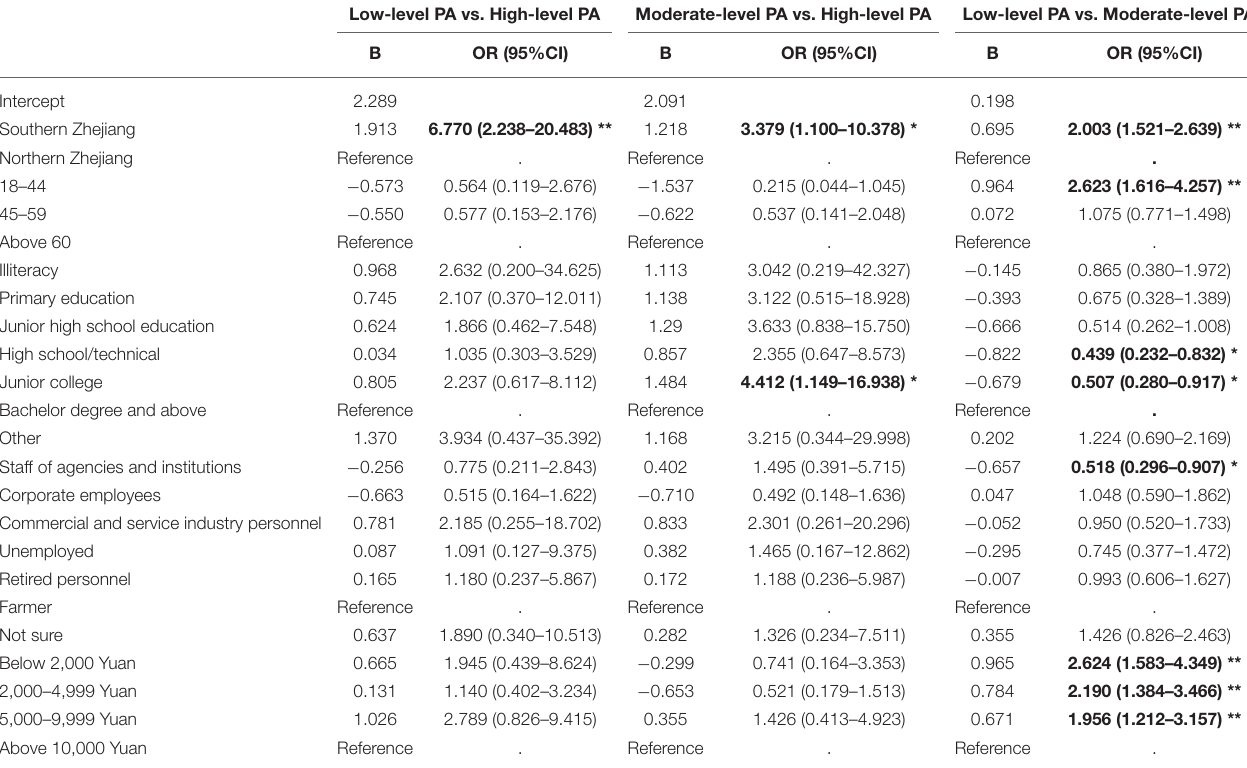
TABLE 4 | Multivariate logistic regression analysis of factors affecting the level of PA of rural residents.